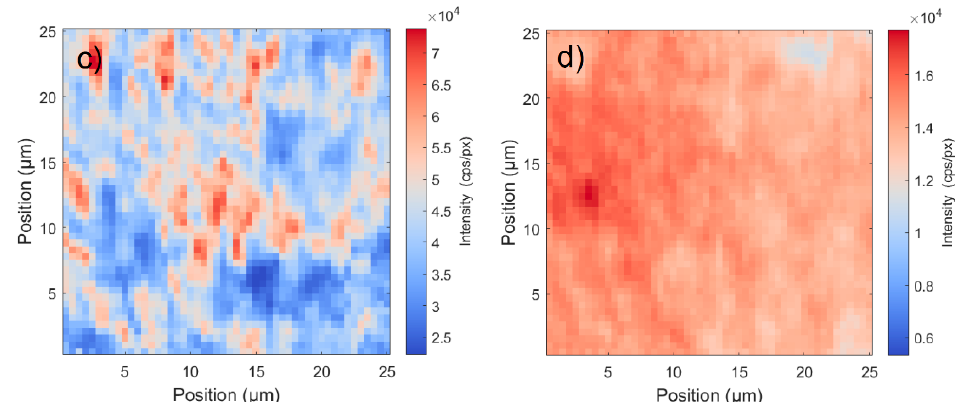
Figure 4. ( a ) Micro-PL spectra at 10 K for sample A acquired in different sample spots spanning a 25 × 25 µm 2 area. ( b ) Pearson correlation map in the same sample area. The black lines correspond to the spatially integrated PL spectra in the same sample area. ( c , d ) PL intensity for P α and P β , respectively, in the same sample area.